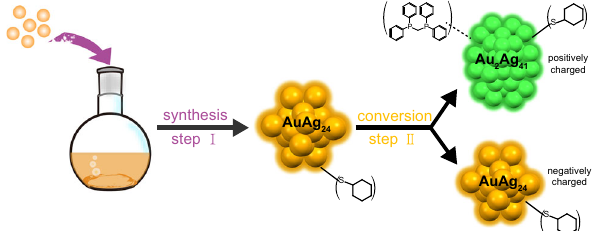
Fig. 5 Schematic diagram of the synthesis route for (Au 2 Ag 41 ) ■ (AuAg 24 ) bi-nanocluster system. Color code: AuAg 24 : orange; Au 2 Ag 41 : did not inform the relationship between the two. We considered three possibilities: (i) AuAg 24 induces the formation of Au 2 Ag 41 in the system; (ii) AuAg 24 is transformed into Au 2 Ag 41 ; and (iii) the two are formed independently.